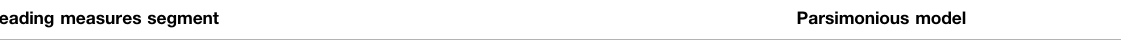
TABLE 1 | Parsimonious models for reading measures on the three segments of Experiment 1. Reading measures segment